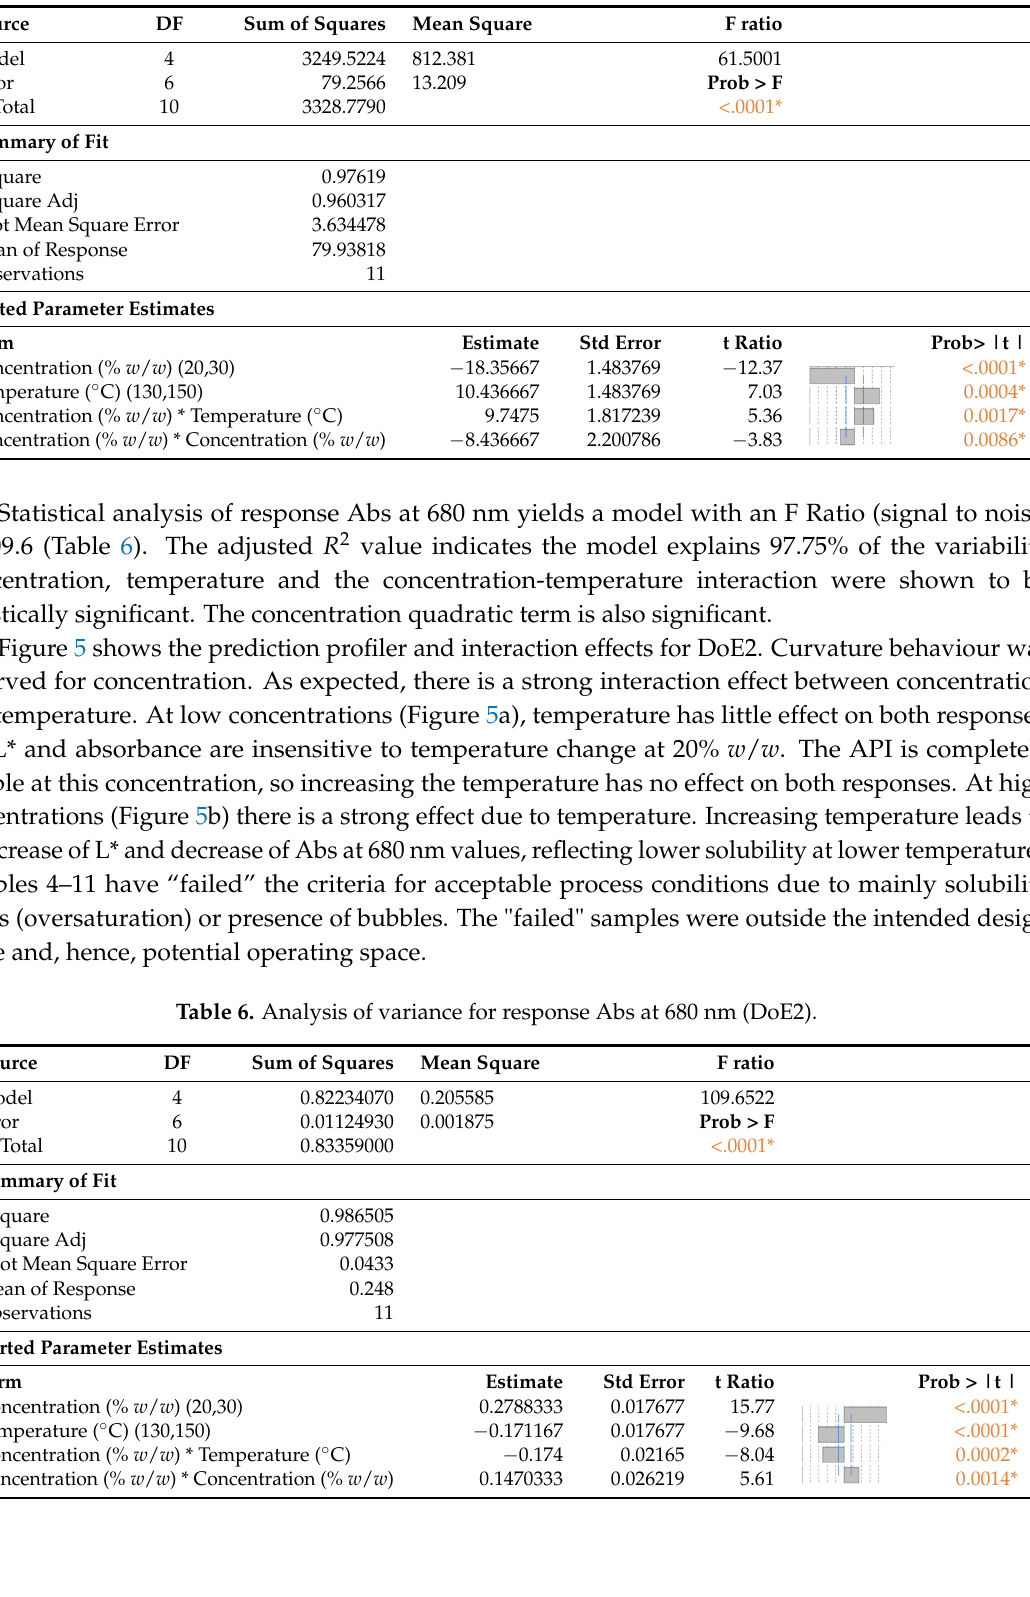
Table 5. Analysis of variance for response L* (DoE2).